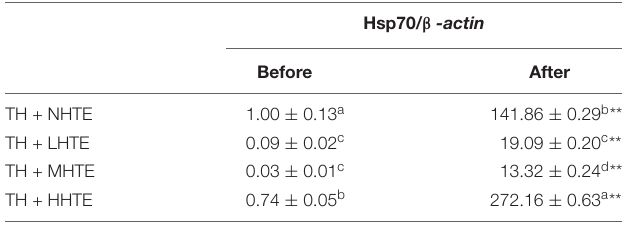
TABLE 3 | The mRNA relative expression levels of heat shock protein 70 (Hsp70) in female flies with thermal hardening and fed a diet containing low, medium, and high concentrations (TH + LHTE, TH + MHTE, and TH + HHTE, respectively) of hsian-tsao extract (HTE) or a non-HTE control diet (TH + NHTE) before and after heat exposure (60 female flies per group, 20 per